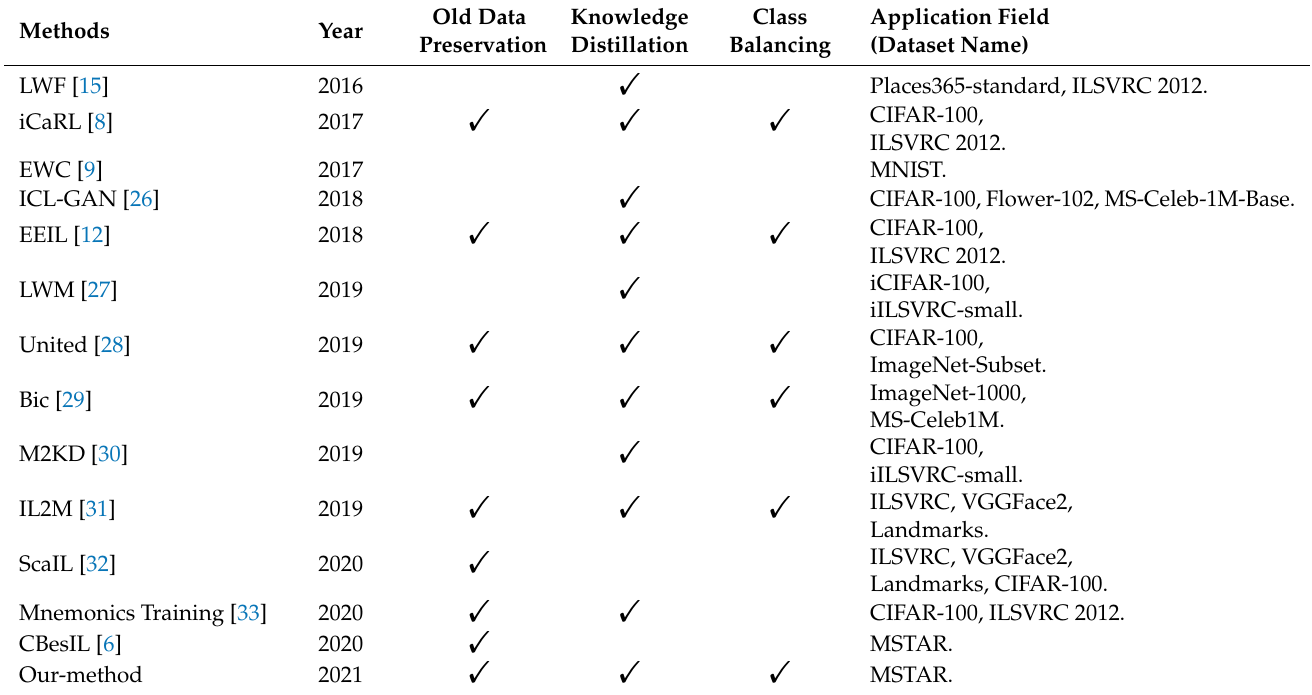
Table 1. Summary of existing incremental learning